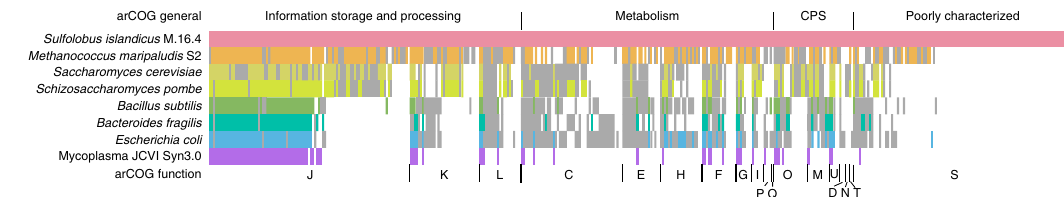
Fig. 5 Shared essential genes across the three domains of life. Heatmap shows the presence of essential (colored) or non-essential (gray) shared NOGs compared with the S. islandicus M.16.4 essential genome. Single-letter codes for functional categories are as follows: J, translation, ribosomal structure, and biogenesis; K, transcription; L, DNA replication, recombination, and repair; C, energy production and conversion; E, amino acid transport and metabolism; H, coenzyme transport and metabolism; F, nucleotide transport and metabolism; G, carbohydrate transport and metabolism; I, lipid transport and metabolism; P, inorganic ion transport and metabolism; Q, secondary metabolite biosynthesis, transport, and catabolism; O, posttranslational modi fi cation, protein turnover, chaperone functions; M, cell wall/membrane/envelope biogenesis; U, intracellular traf fi cking, secretion, and vesicular transport; D, cell cycle control and mitosis; N, cell motility; T, signal transduction; S, function unknown. CPS, cellular processes